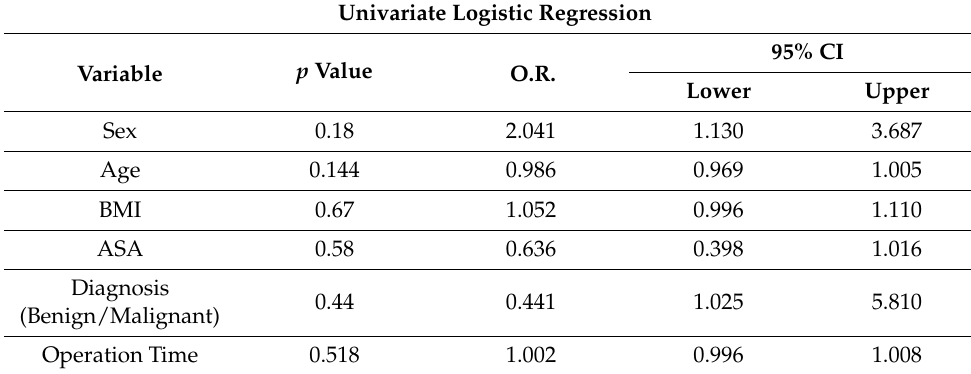
Table 3. Univariate analysis for <24 h discharge.